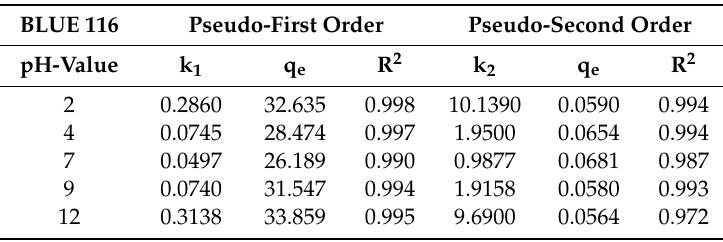
Figure 4. Kinetic adsorption model for Reactive Blue 116 at different pH values. Table 3. Return of kinetic model data for Reactive Blue 116.